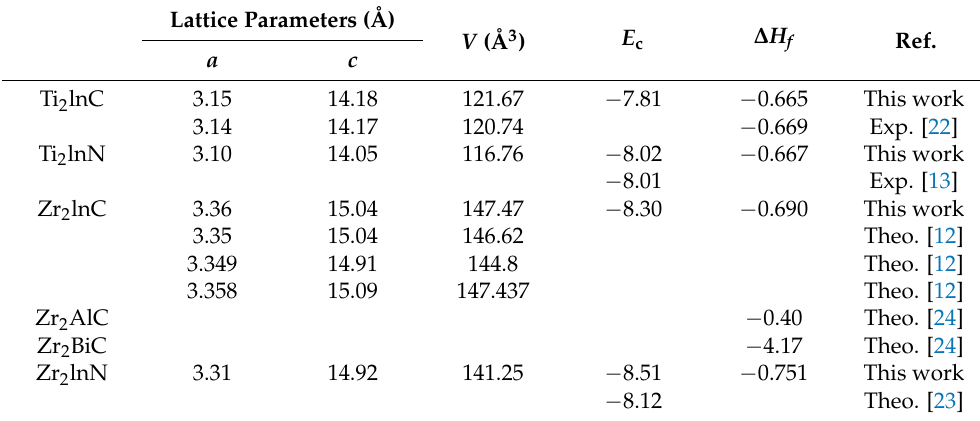
Table 1. The lattice parameters, cohesive energy E c (in eV/atom), and formation enthalpy ∆ H f (in eV/atom) of M 2 InX (M = Ti, Zr and X = C, N) MAX phases. Lattice Parameters